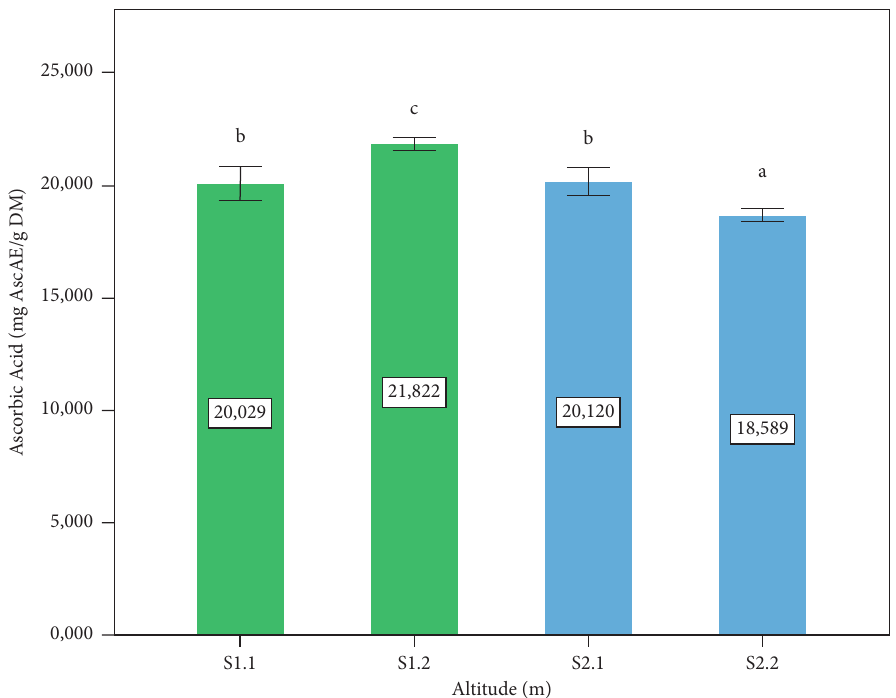
Figure 6: Ascorbic acid content of the P. lentiscus L. leaves at different altitudes. Data are means of three replicates. Vertical bars represent the standard deviation of the mean. Values not sharing a common letter indicate a significant difference at p ≤ 0 . 05, based on the SNK test. AscAE: ascorbic acid equivalent. DM: dry matter. S: site, S1.1 � 1400m, S1.2 � 1120, S2.1 � 780m, S2.2 � 720m.